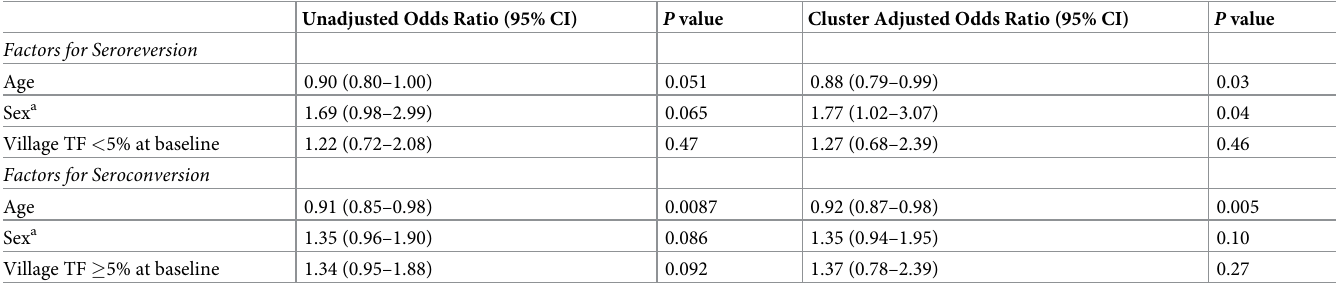
seroconversion survey used the same bead sets, and the mean increase in log MFI-BG was 2.49 ( P < 0.001). There were 31 (2%) children who experienced a single or transient seroconversion or seror- eversion (Groups 3 and 6). We examined the effect of MFI-BG values falling in the indetermi- nate range on these findings. Only one child (3% of the 31) had the single change with a value of MFI-BG in the indeterminate range. The other children in this group did not have MFI-BG values in the indeterminate ranges. The data suggests that these transient changes in serostatus are real and not due to values in the indeterminate ranges. Twenty of the 26 children (76.9%) who had one transient seroconversion were under age 6. Table 4. Multivariable logistic regression analysis of factors associated with seroreversion or seroconversion in the longitudinal